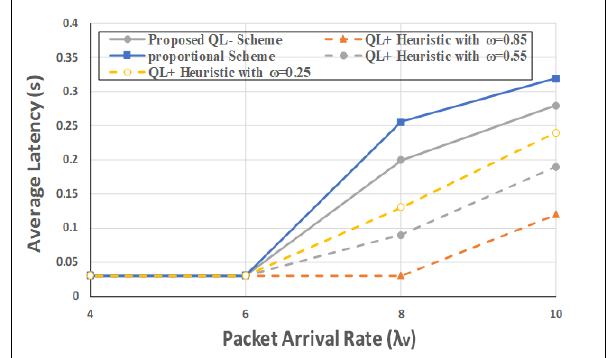
Fig ure 7. Average Latency as a function of the V2X UEs packet generation rate λv